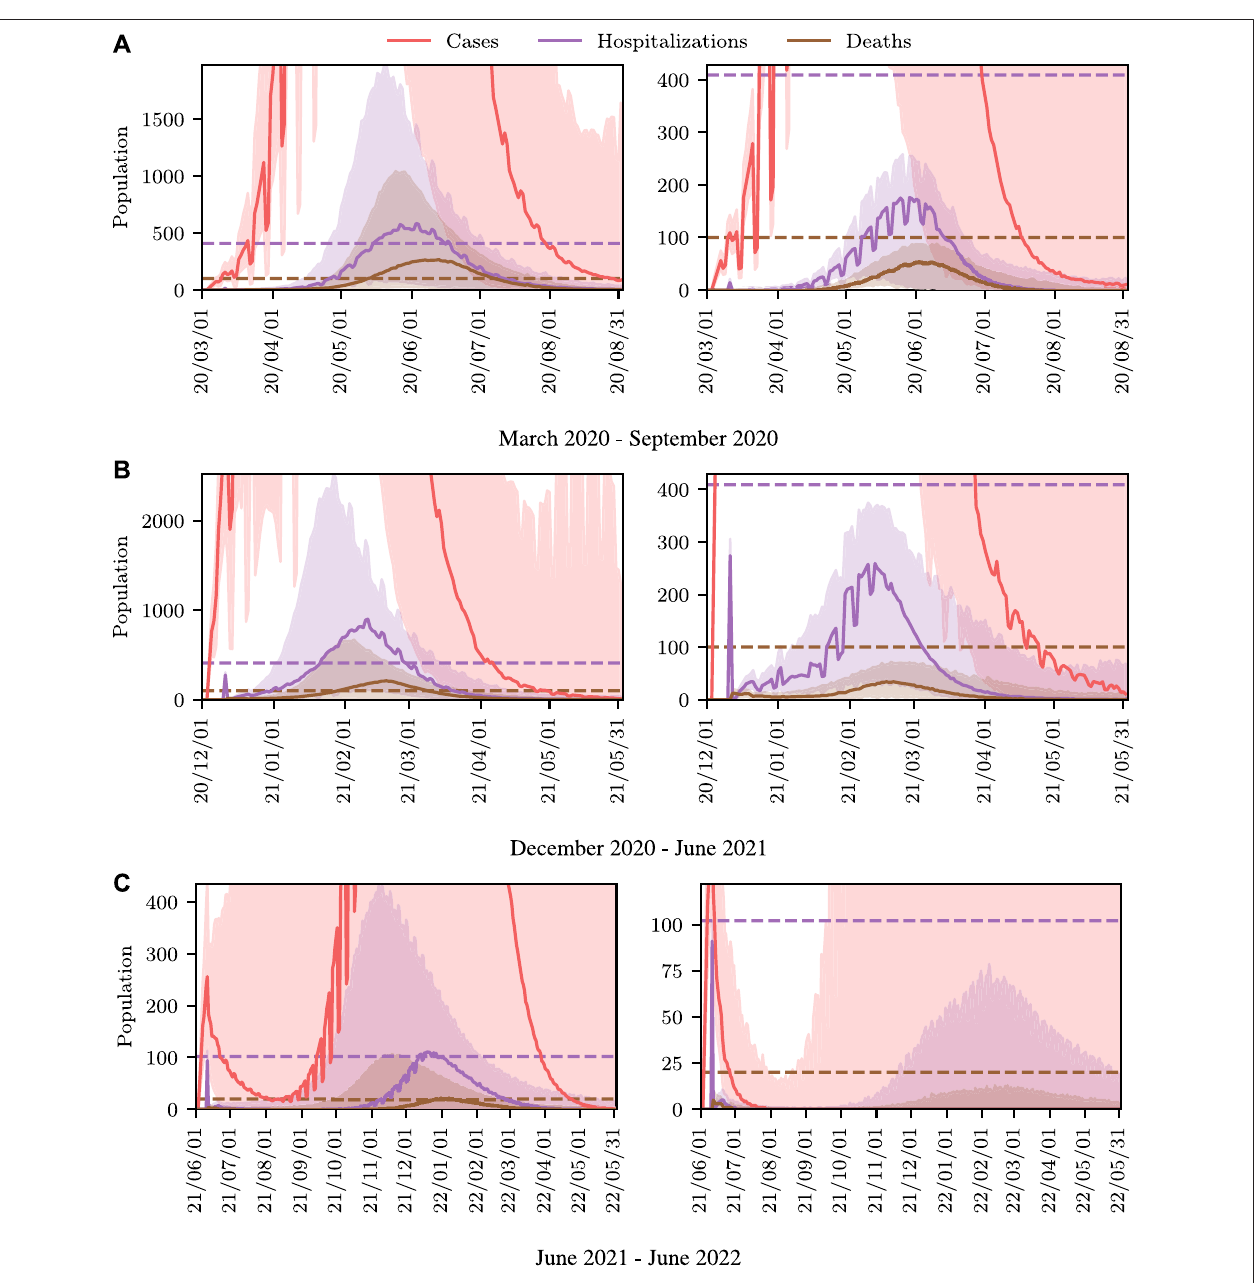
FIGURE 10 | Aggregated statistics from 1,000 FRED simulations of a COVID-19 outbreak in the Seattle metropolitan area. We plot the median and con fi dence intervals between the 3rd and 97th percentiles of the daily cases, hospitalizations, and deaths. Each row shows a different period of time with different starting conditions and policy goals. The goal in these simulations is to keep the number of daily hospitalizations and deaths below the thresholds speci fi ed by dashed lines in matching colors. The left column shows the evolution of the outbreak when no control is applied. The right column shows the evolution of the outbreak when controls provided by our method are applied. As expected, without control the number of hospitalizations and deaths quickly exceeds the thresholds whereas in the controlled simulations it is ensured that all the desired conditions are met throughout the simulation